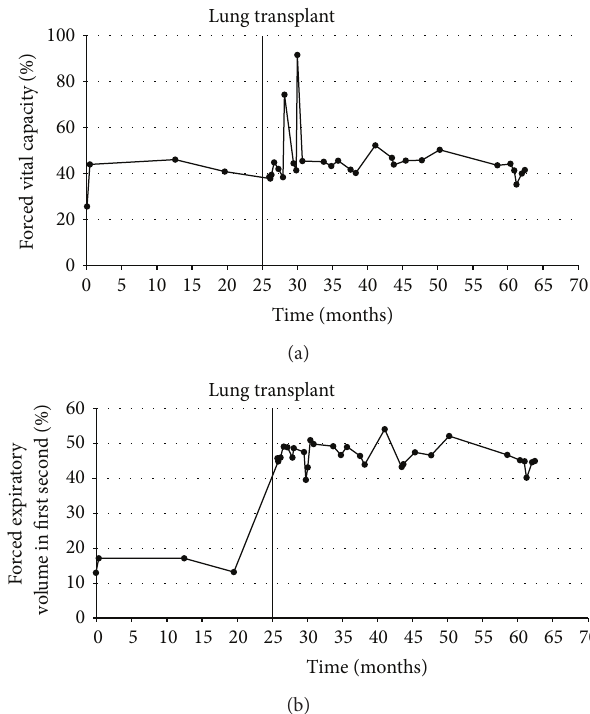
Figure 1: Time course of the pulmonary function parameters: (a) forcedvitalcapacityand(b)forcedexpiratoryvolumeinfirstsecond.